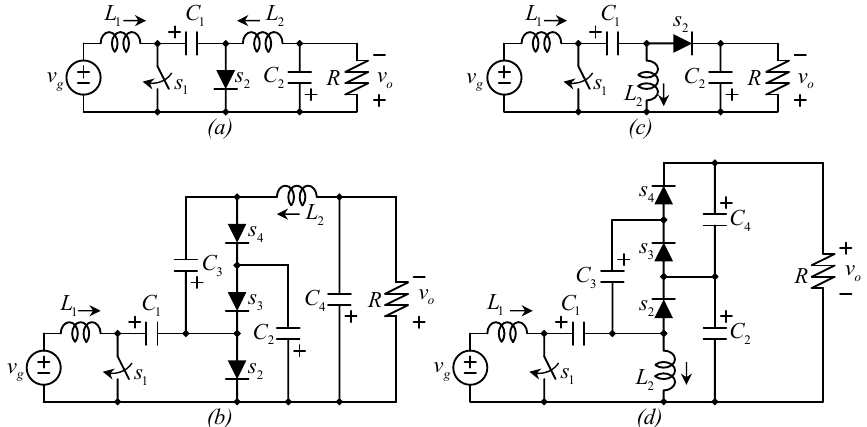
Figure 27. Other traditional converters and their multiplier version: ( a ) the Cuk converter, ( b ) multiplier Cuk converter [60], ( c ) the SEPIC converter, and ( d ) multiplier SEPIC converter [61].